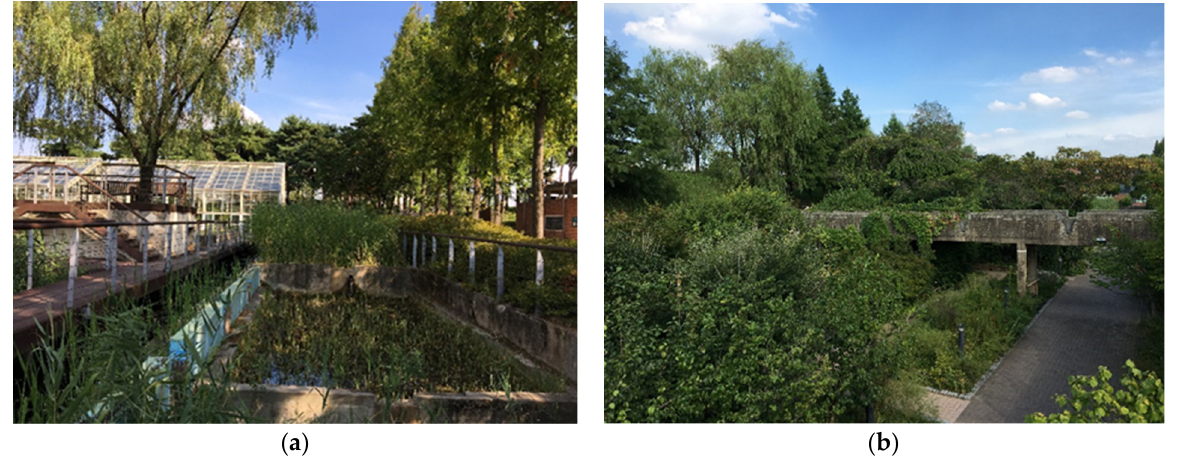
Figure 5. Seonyudo Park: ( a ) water purification basin; ( b ) transition garden. Source: Author’s photographs.